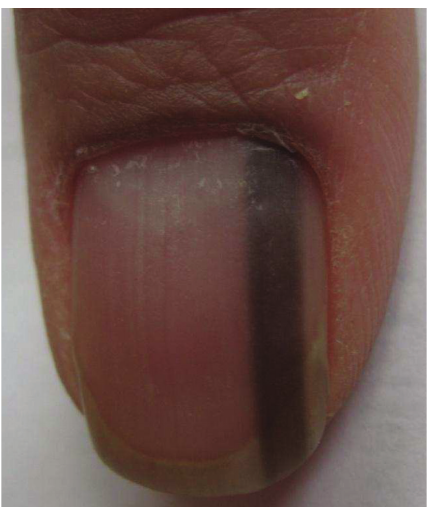
Figure 4: Nail apparatus lentigo in an adult.